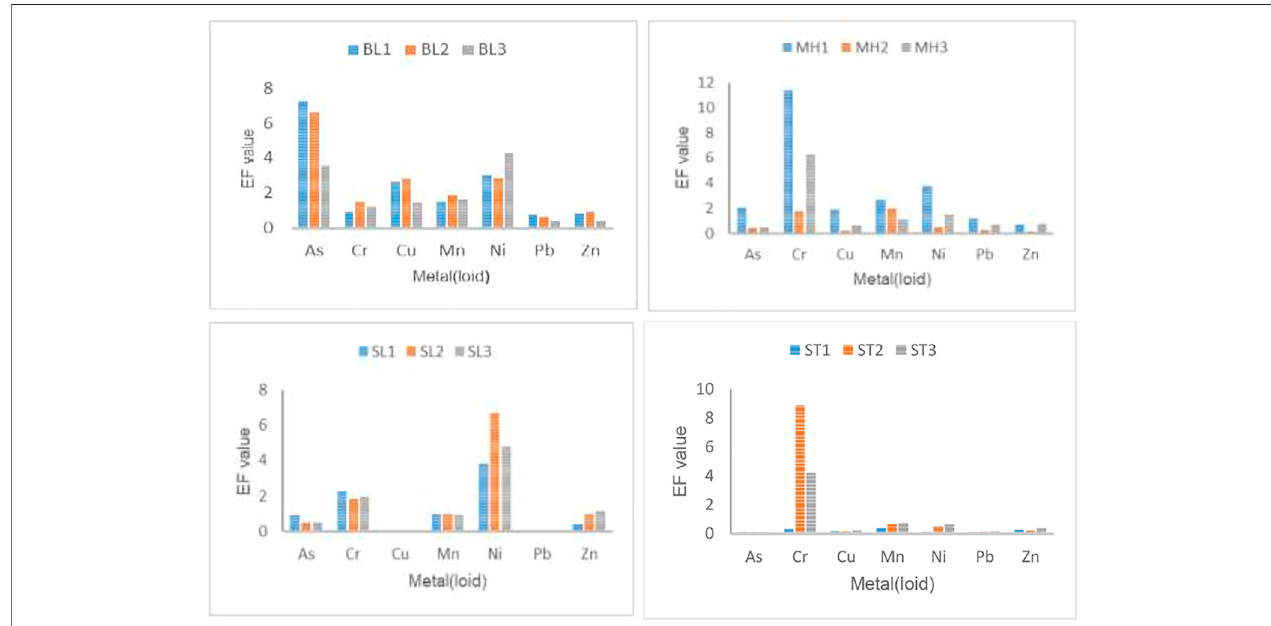
FIGURE 3 | Enrichment factors (EF) of metal(loid)s collected from different sites of the four rivers in the Olifants River Basin.